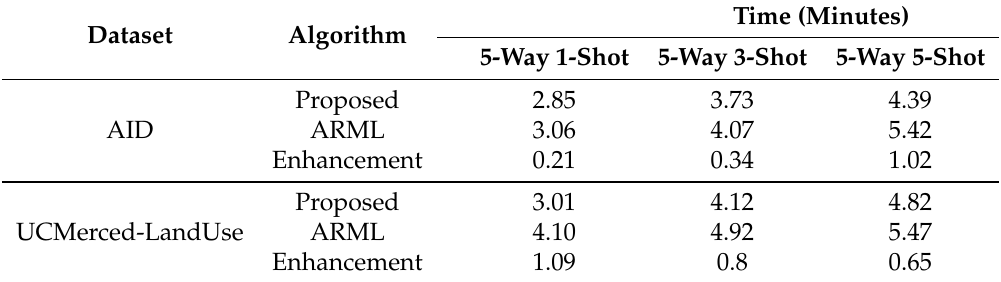
Table 4. Run time comparison.